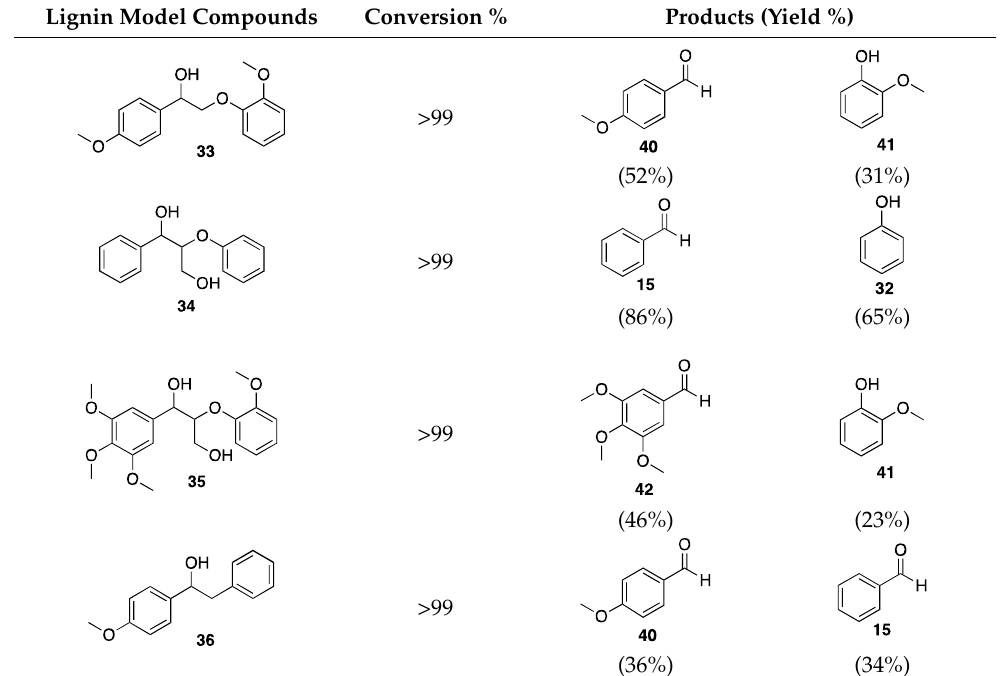
Table 1. Set of tested model compounds.